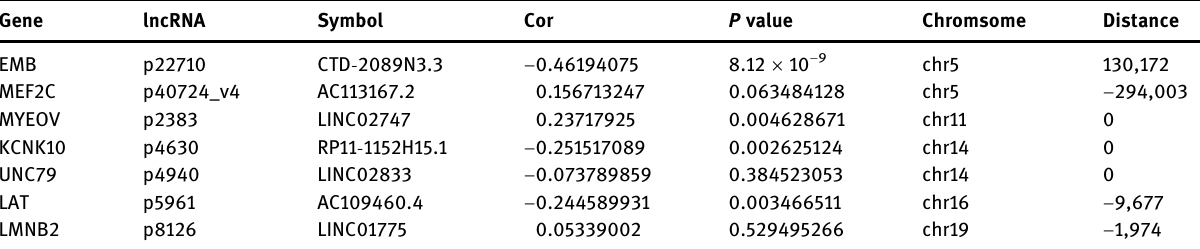
Table 2: Seven EMT - related diagnostic lncRNAs regulated their nearby genes via the cis - regulatory manner